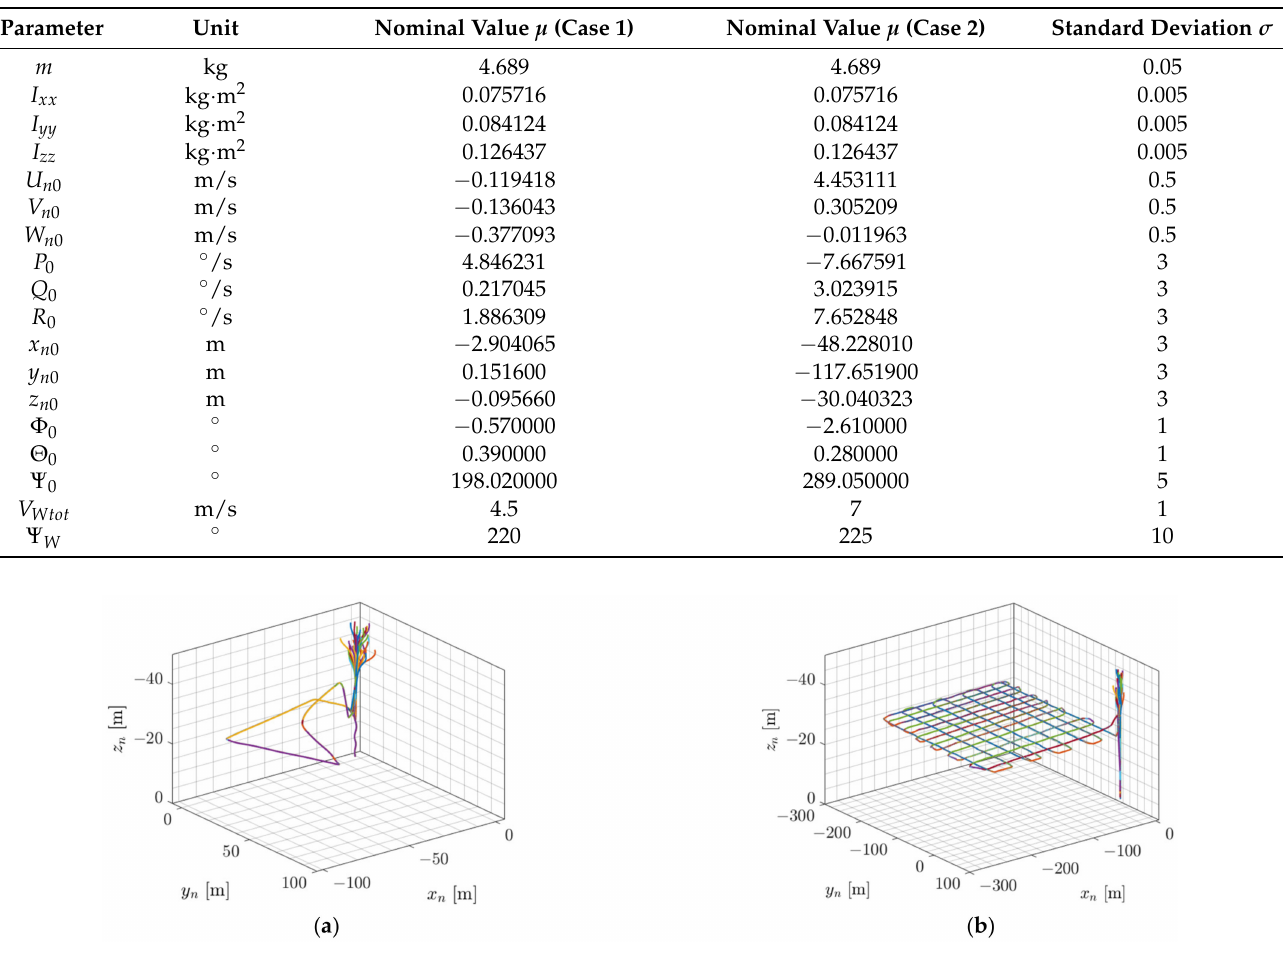
Figure 23. Quadrotor trajectories: ( a ) case 1 and ( b ) case 2. The mean, minimum, and maximum values of consumed energy are presented in Table 8. Table 8. Statistics for the obtained